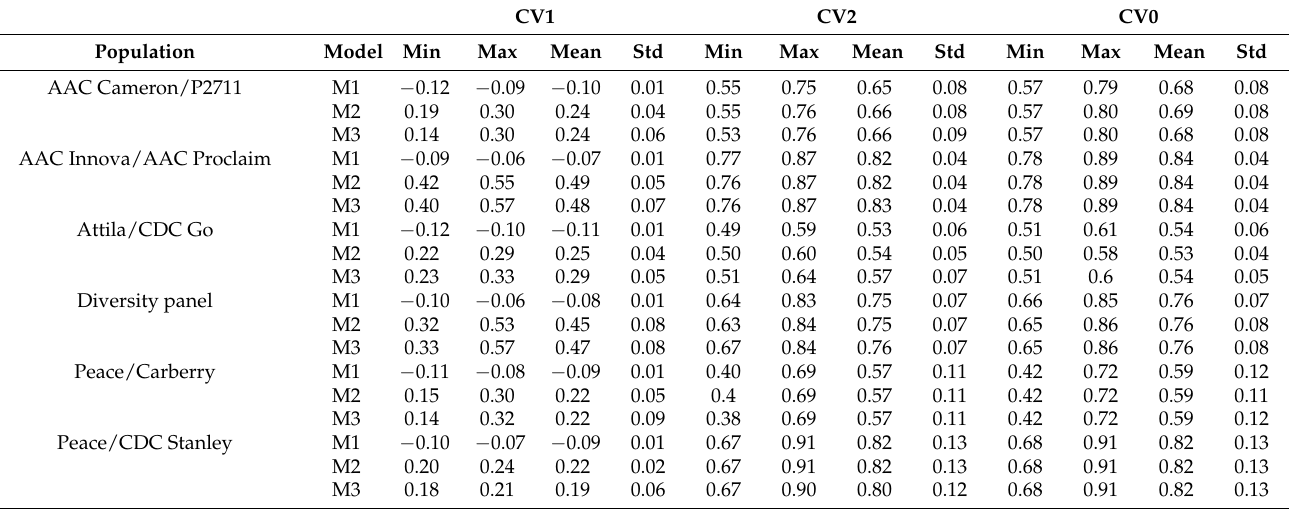
Table 2. The minimum (min), maximum (max), mean, and standard deviation (Std) of stripe rust prediction accuracies for six spring wheat populations based on three models (M1, M2, and M3) and three random cross-validations scenarios (CV1, CV2, and CV0). Each value was based on 40 iterations. See Table S1 for details on prediction